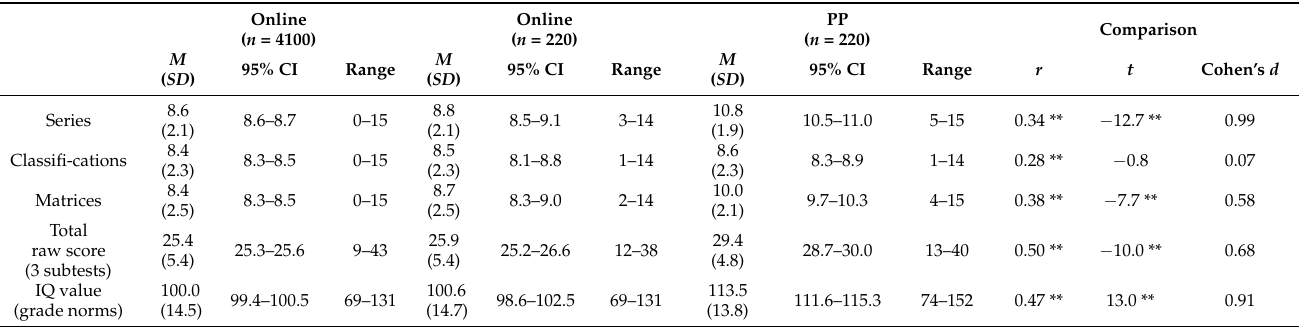
Table 3. Raw scores of the CFT 20-R online and PP versions as well as results of their comparisons (correlation; t